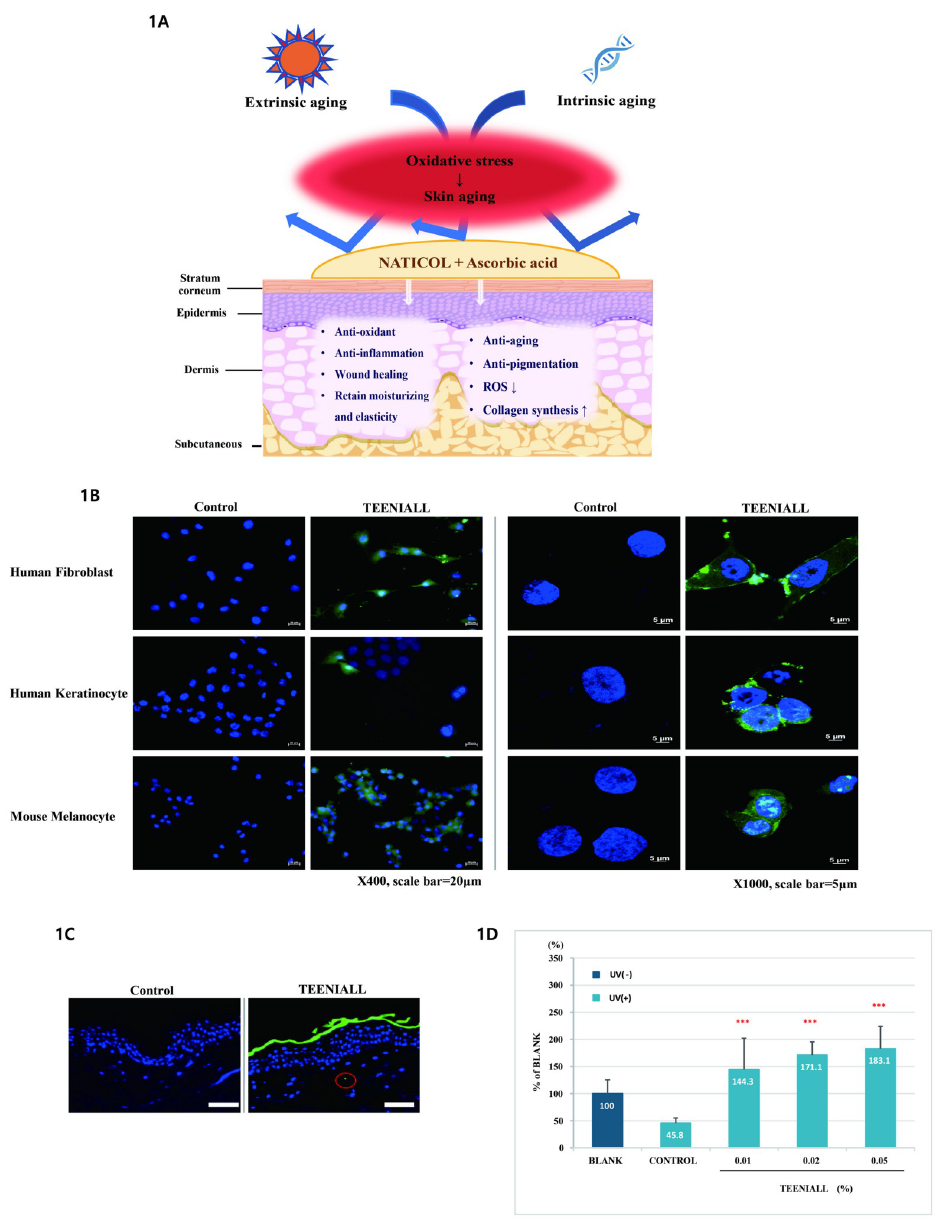
Fig 1. CONSORT 2010 flow